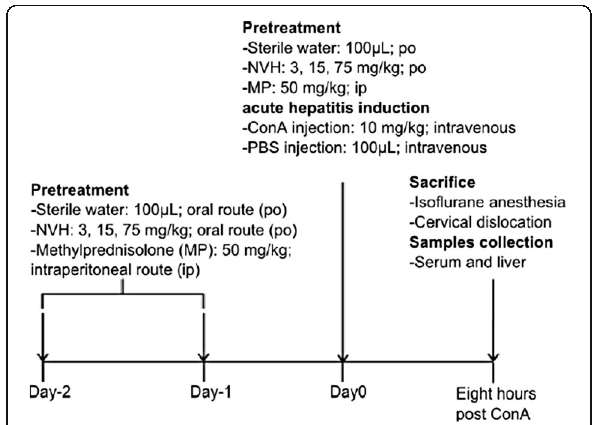
Fig. 2 Diagram ConA-model experimental